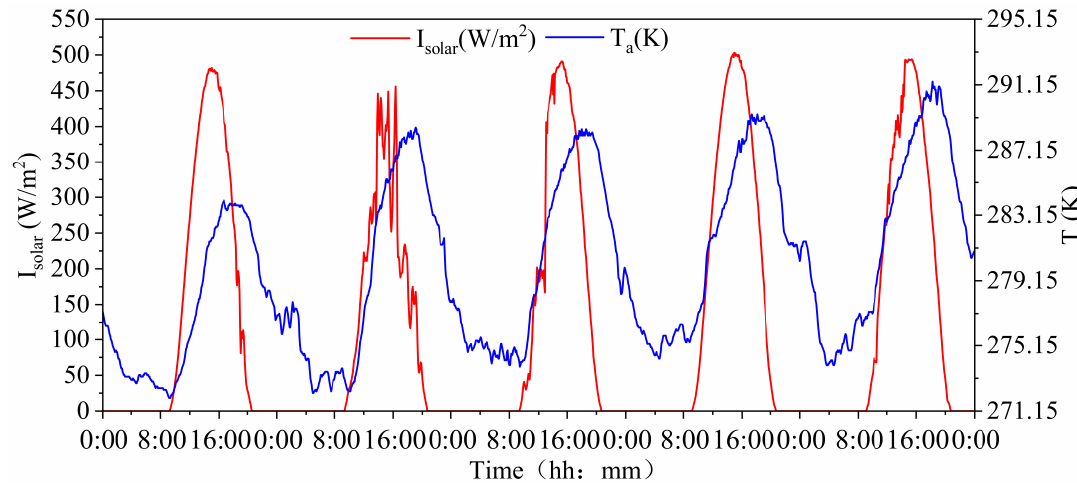
Figure 10. I solar and T a vs. operation time.